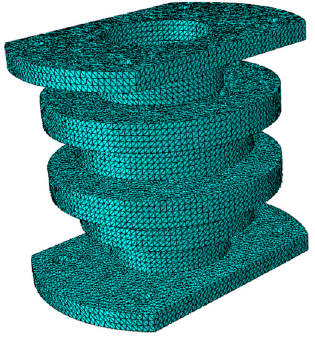
Figure 11. Finite element model of periodic structure support.